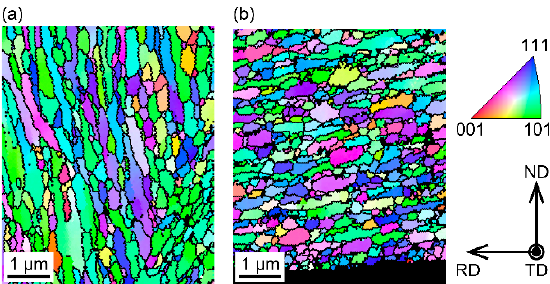
Figure 2. Inverse pole figure (IPF) maps of chip specimen ( a ) at center in the thickness direction and ( b ) near rake face.